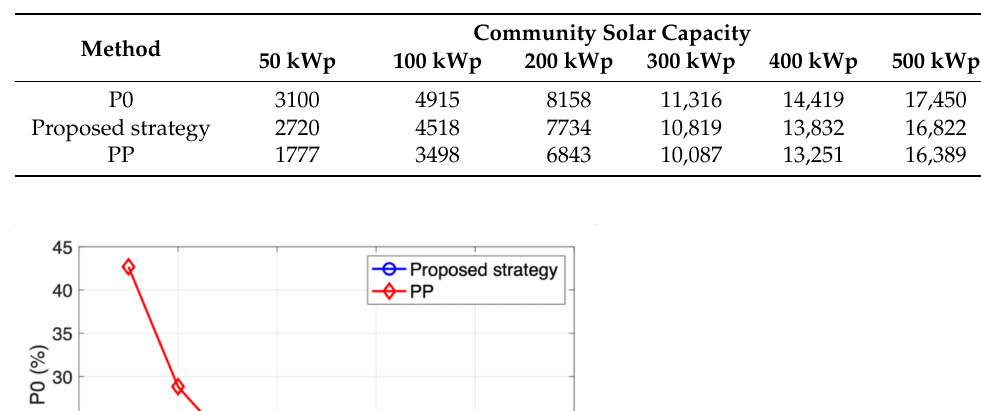
Table 2. Overall monthly electricity bill savings for the members ($/month).